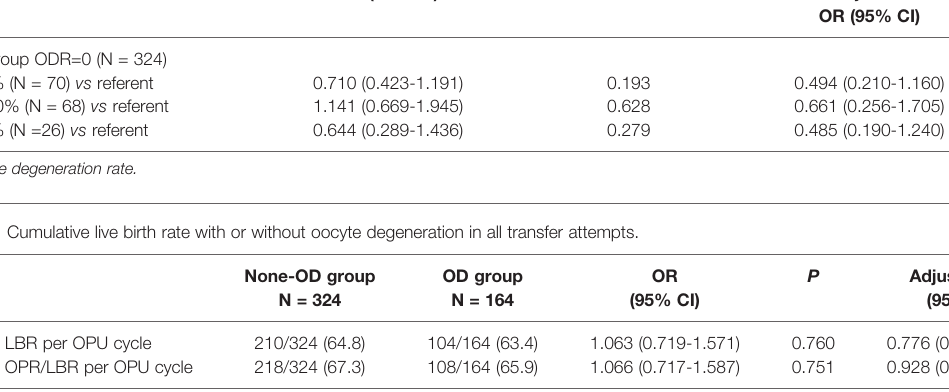
TABLE 3 | Odds of live birth rate per OPU cycle with increasing oocyte degeneration rate. Comparison